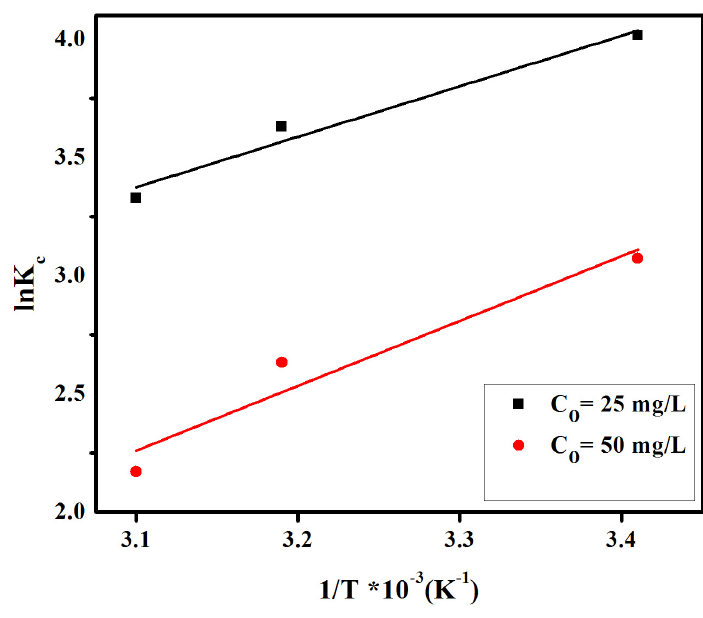
Figure 12. Plot of lnk c verses 1/T for congo red dye on anion exchange membrane EBTAC. Table2. Thermodynamic parameters for adsorption of CR on anion exchange membrane EBTAC. C o